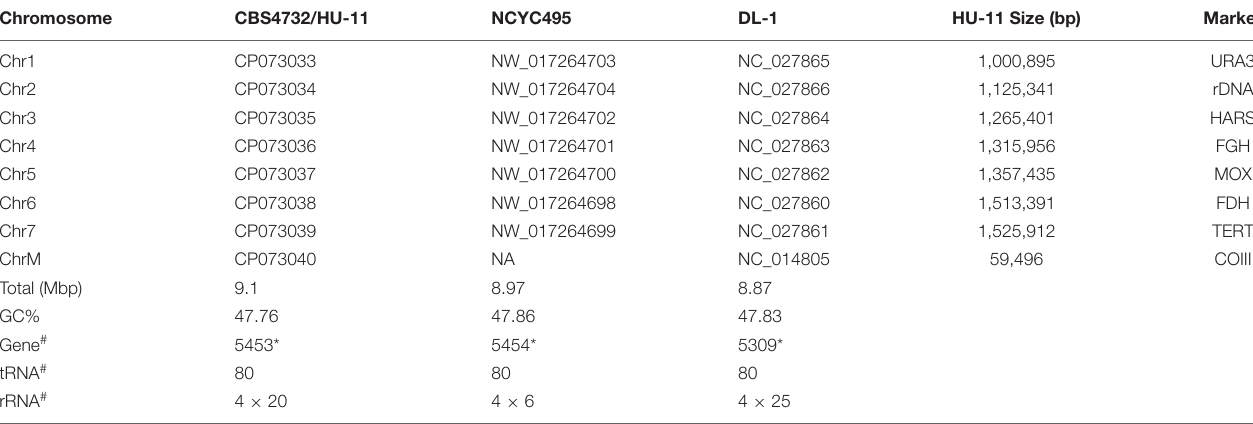
TABLE 1 | Genomes of three basic Ogataea polymorpha strains.